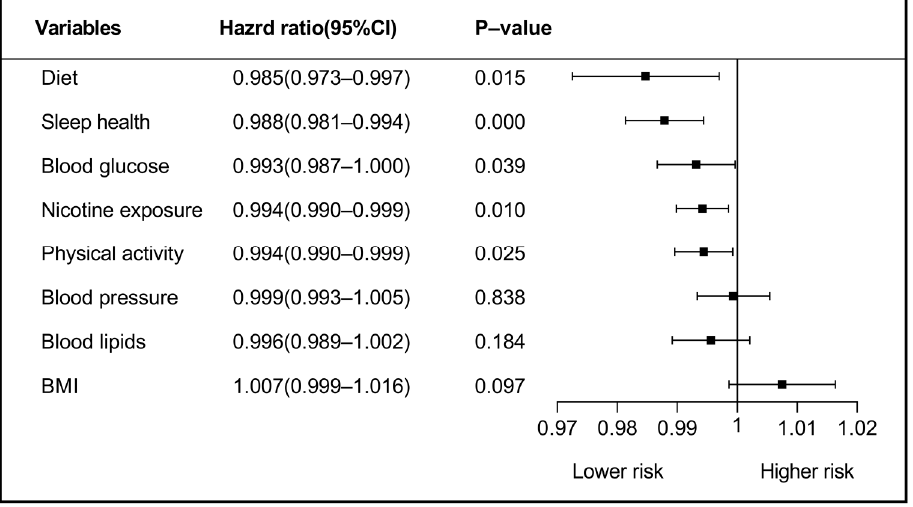
Figure 2. Cox regression of the 8 metrics of LE8 on the prediction of MACEs. BMI, body mass index. 174 × 99 mm( × DPI). Table 3. Interaction analysis of Blood lipids, BMI and BP with other 5 metrics † in LE8 ( n = 339).